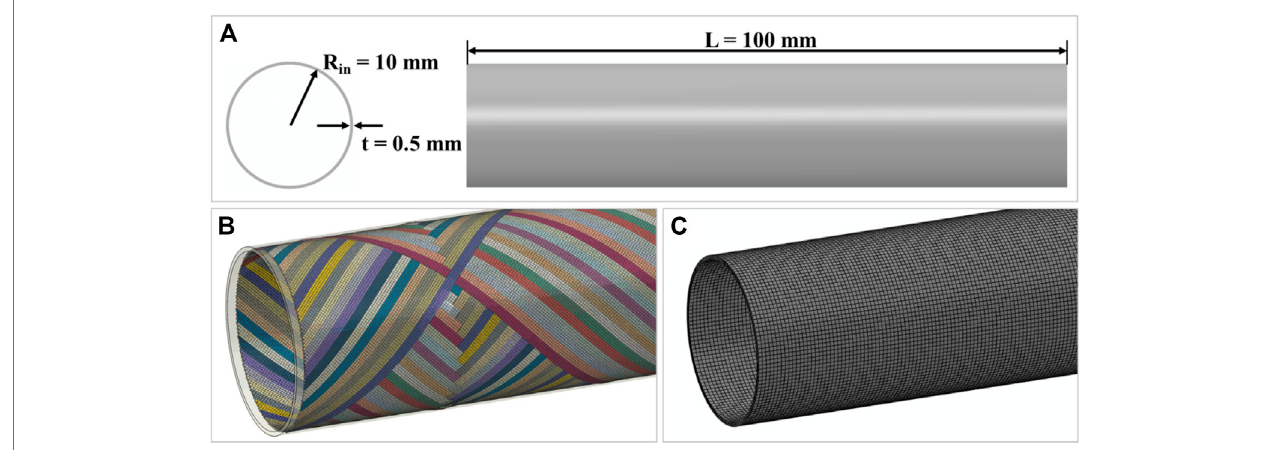
FIGURE 7 | The FE model of the nuclear cladding tube: (A) the dimension of the tube with a length of 100 mm and a thickness of 0.5 mm; (B) the wound mesh integrated with the matrix using embedded constraint; (C) the laminated tube. The global fi ber volume fractions are identical at 28%.